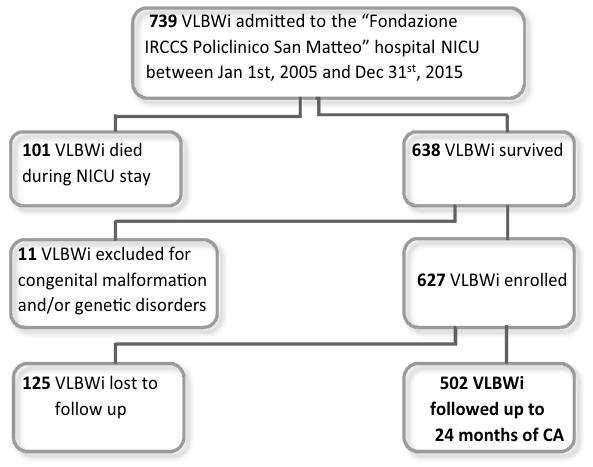
Figure 1. Participant flow